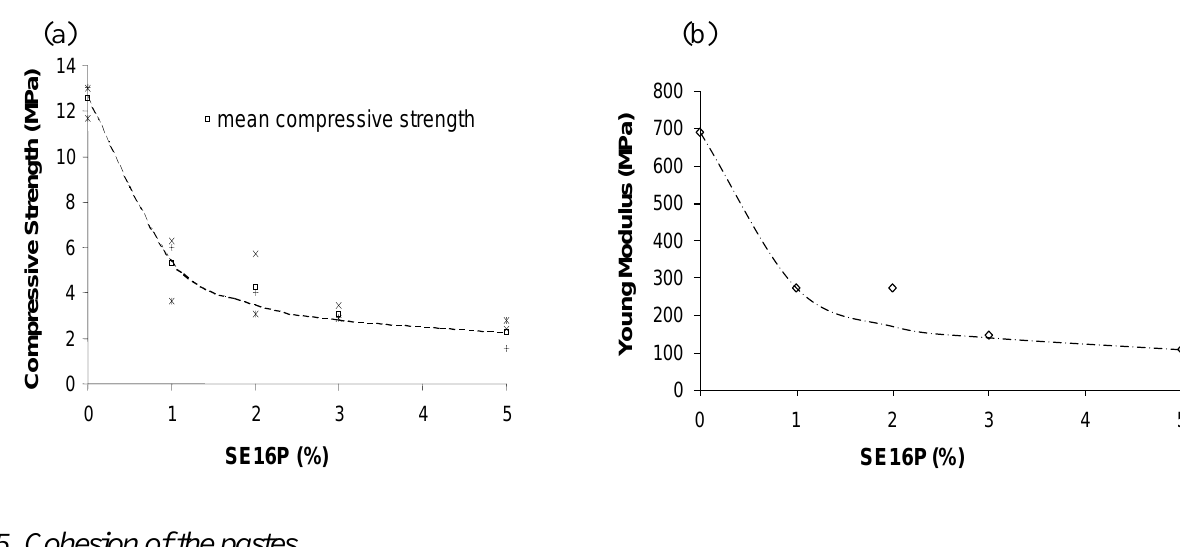
Figure 5. ( a ) Compressive Strength and ( b ) Young’s Modulus for compression as a function of SE16P